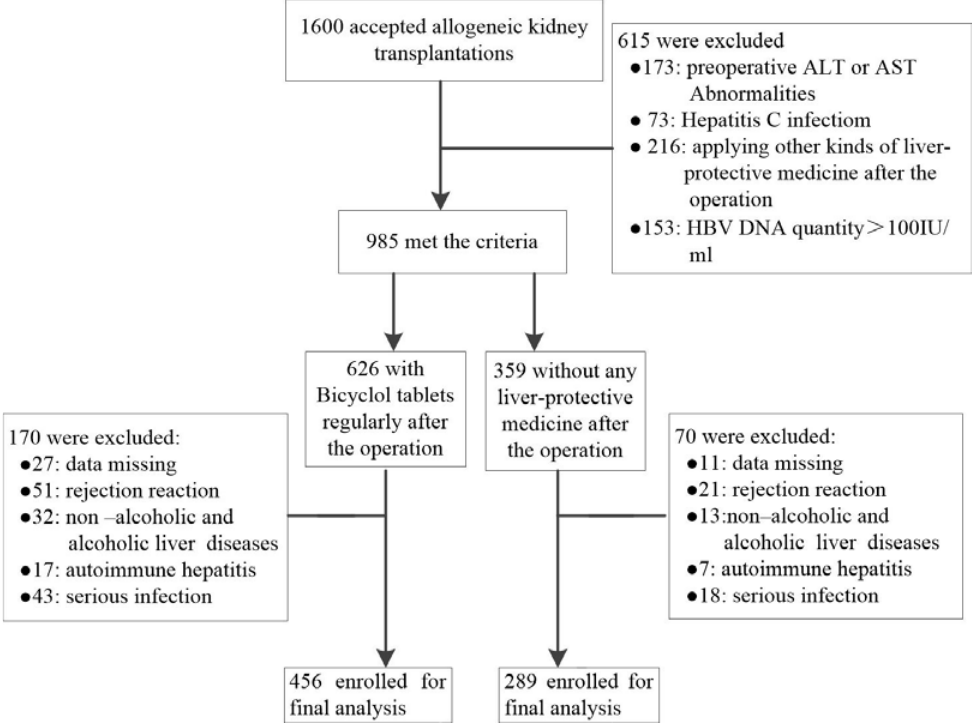
Figure 1: Case selection flow